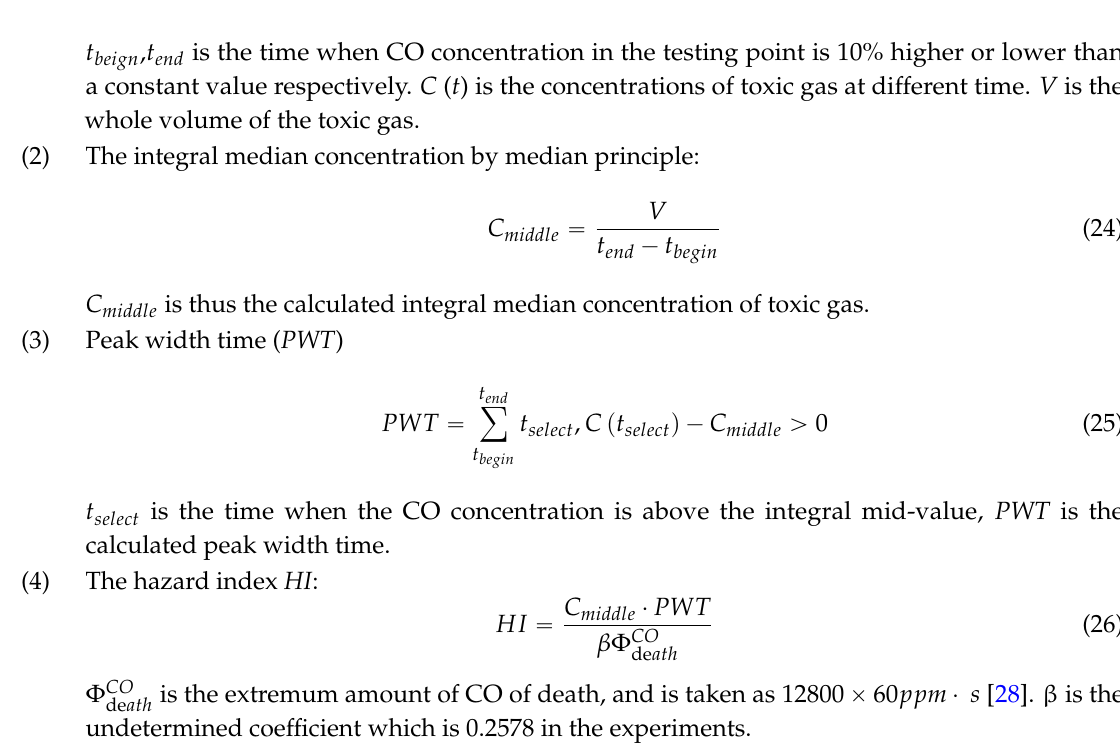
Figure 12. CO concentration generated by material A and B when heat flux is 45 kW/m 2 .